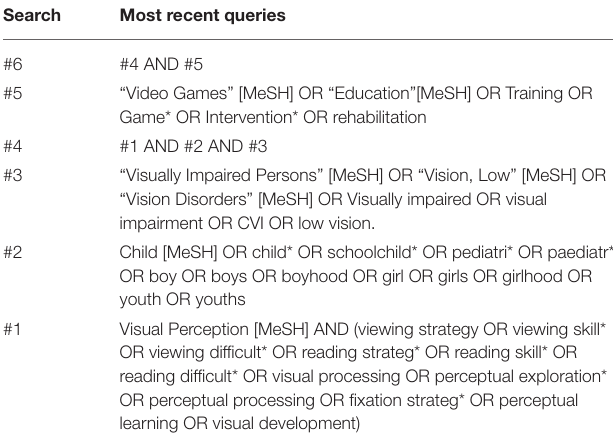
TABLE 2 | Inclusion